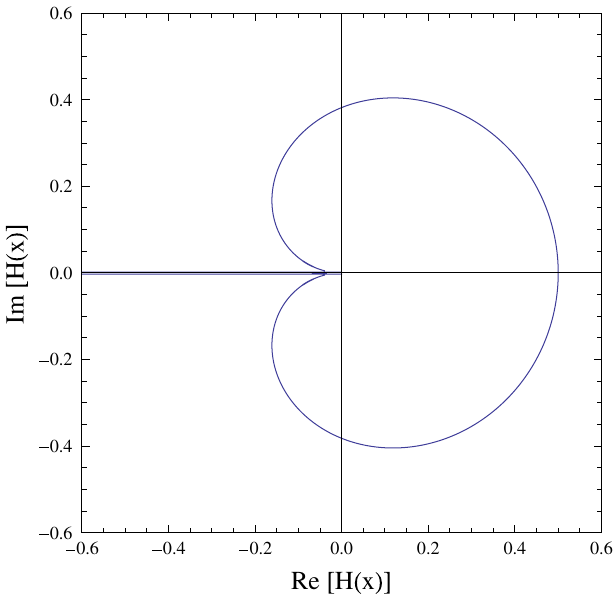
FIG. 2. (Color) Stability diagram for the galaxy distribution, where H ð x Þ is the right-hand side of Eq.